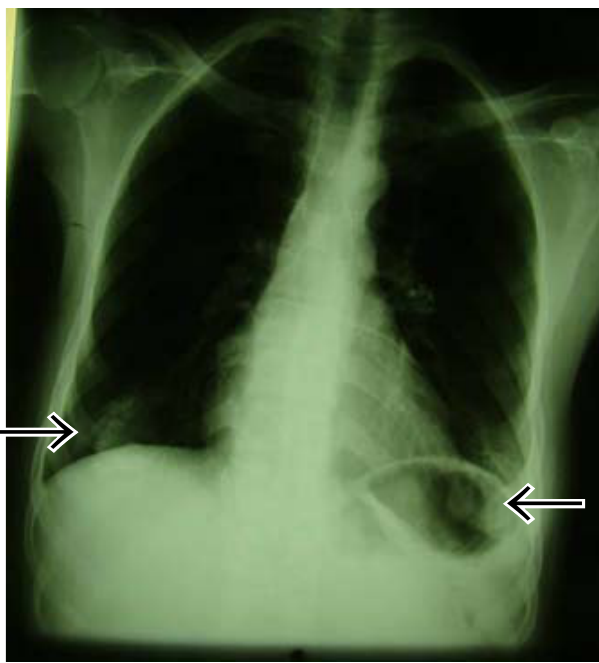
Fig. 10a. Frontal chest X-ray showing bilateral cutaneous neurofibromas of the areola projecting over the lung fields.